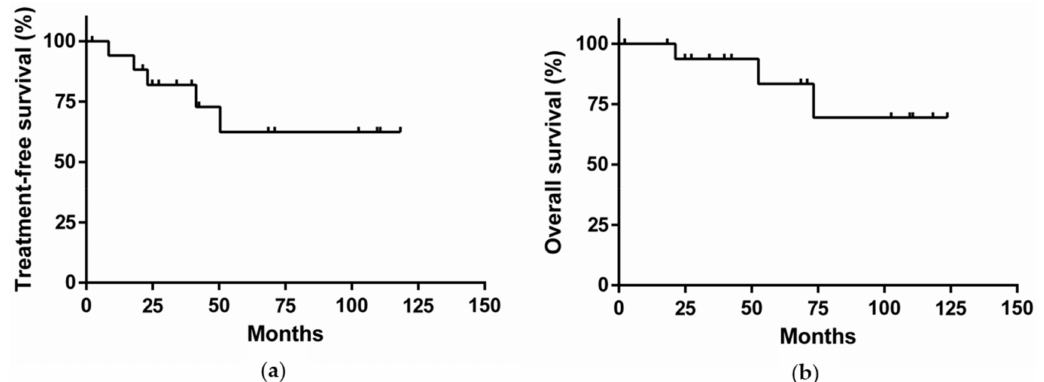
Figure 1. ( a ) Treatment-free survival of the cohort; ( b ) Overall survival of the